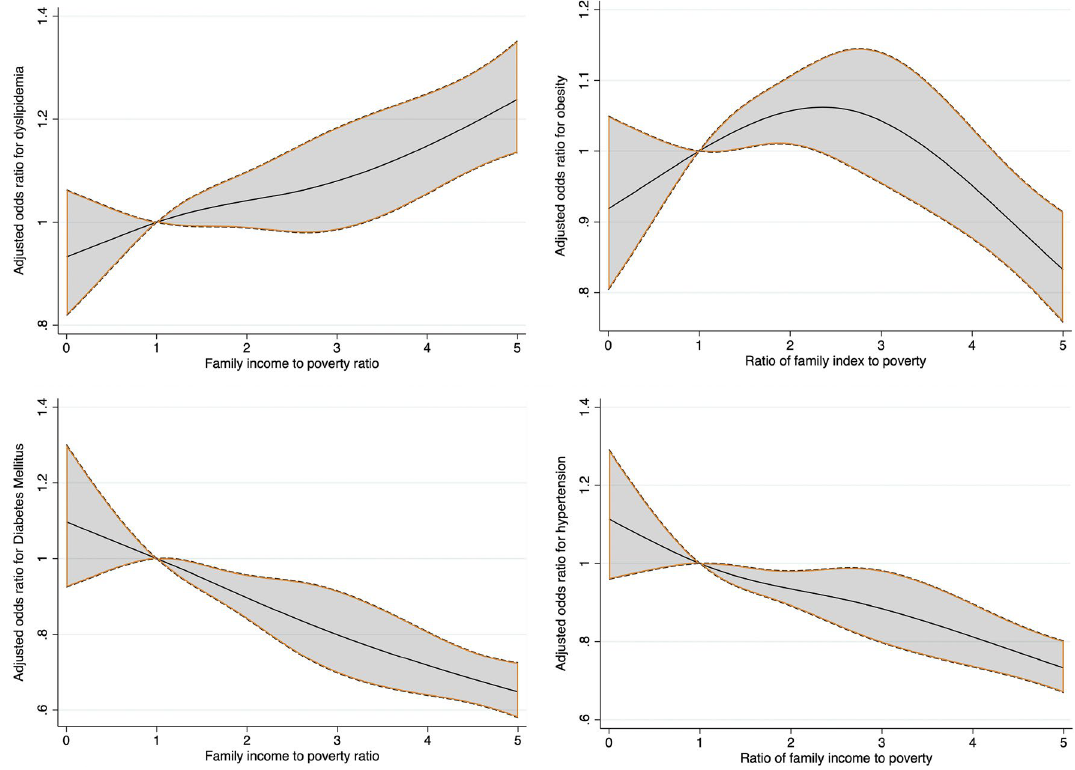
Figure 1. Restricted cubic splines showing relationship between PIR and presence of cardiovascular risk factors.